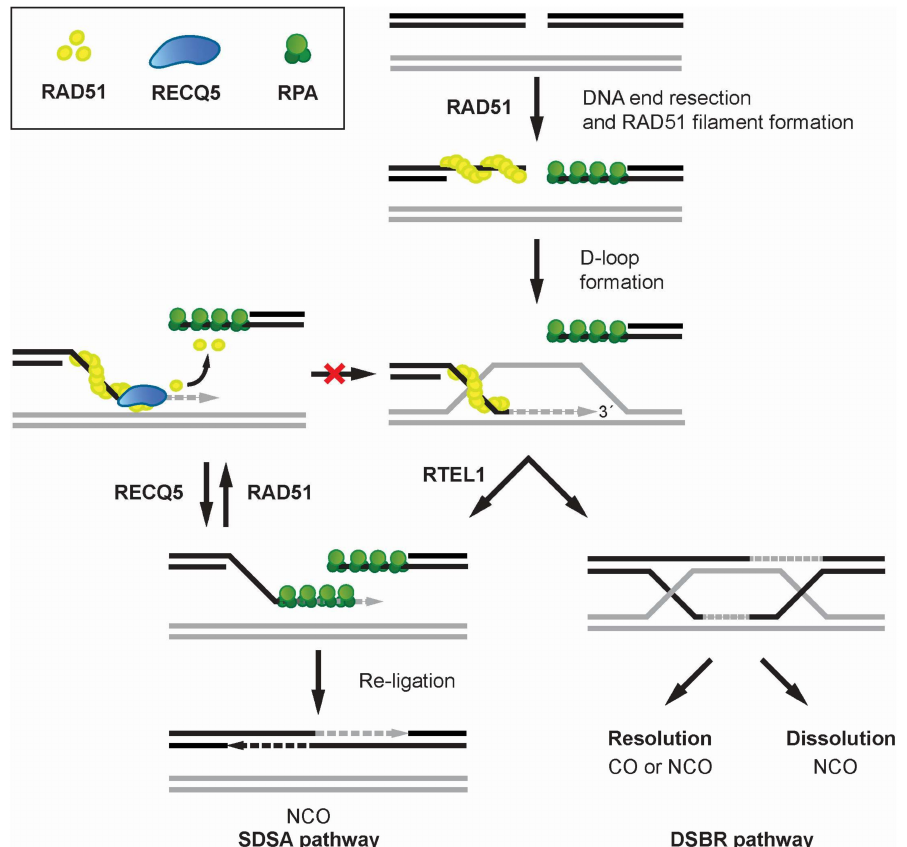
Figure 2. Proposed model for the role of RECQ5 in the suppression of crossovers during homologous recombination repair. RECQ5 promotes the SDSA sub-pathway of HR by disrupting RAD51 filaments formed on ssDNA after RTEL1-mediated unwinding of the extended D-loop. This prevents D-loop reassembly and its conversion to double-Holliday junction, which can be resolved to crossover (CO) or non-crossover (NCO)